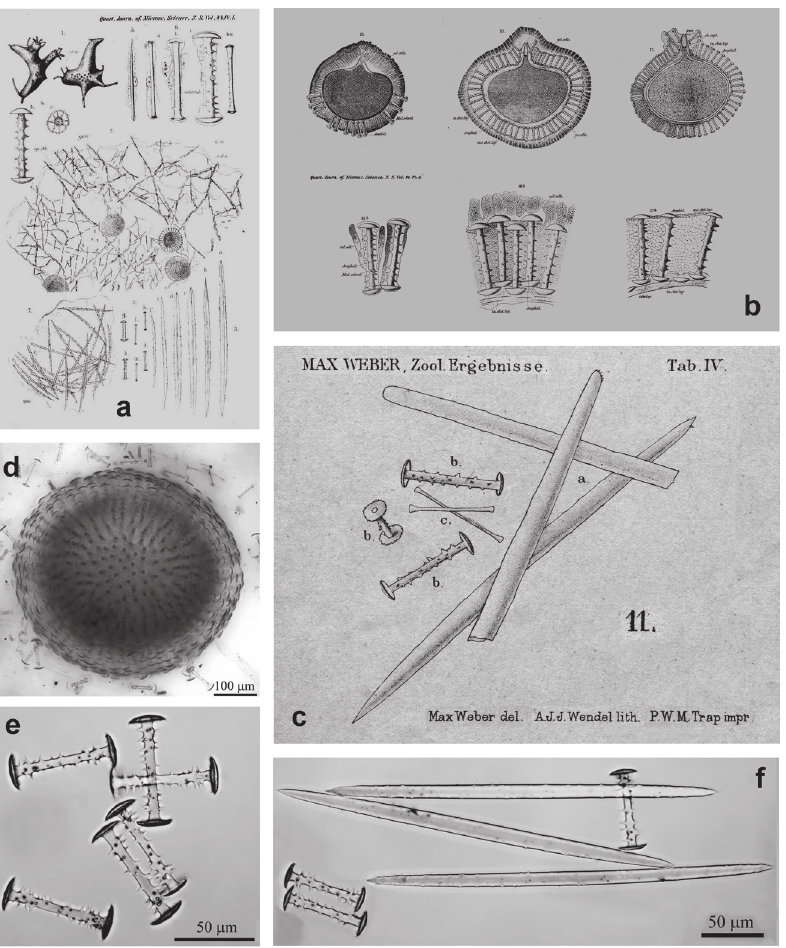
Fig. 6. Umborotula bogorensis (Weber, 1890) (as Ephydatia bogorensis Weber, 1890 and E . blembingia Evans, 1901). a–c . Diagnostic morphotraits from plates in original descriptions. d–f . Gemmule and spicules (LM) of E . blembingia from the type, BMNH 1901:10:22:1−2. a–b. Modified from Evans (1901). c. Modified from Weber